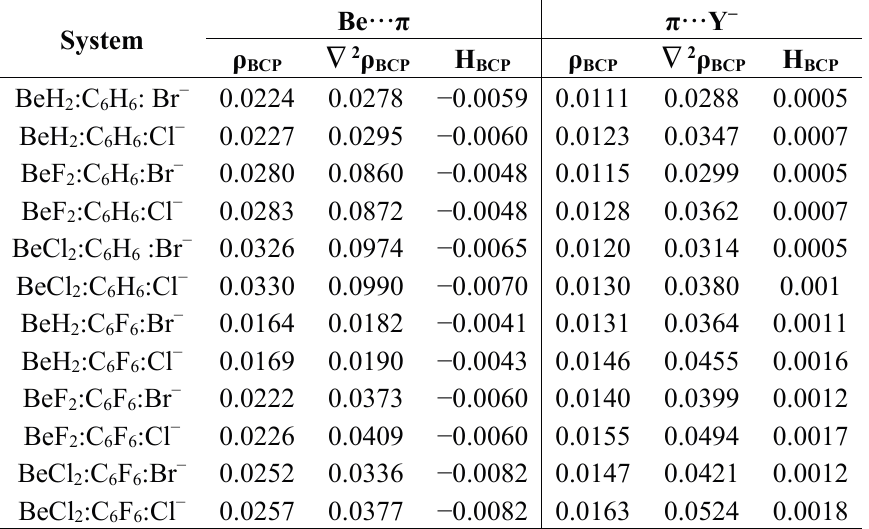
Table 8. AIM parameters (in au) for the BCPs corresponding to the Be··· π and π ···Y interactions in the ternary systems, the electron density, ρ BCP , its Laplacian, ∇ 2 ρ BCP , and the total electron energy density, H BCP .